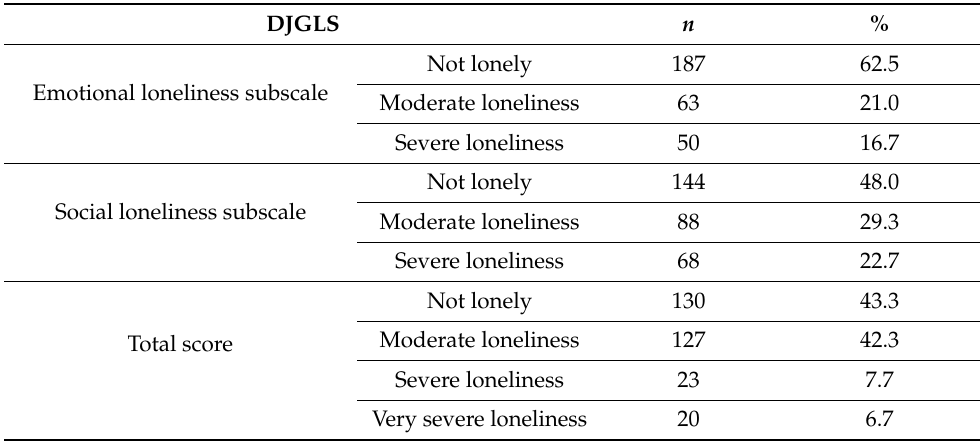
Table 4. Subjects’ DJGLS